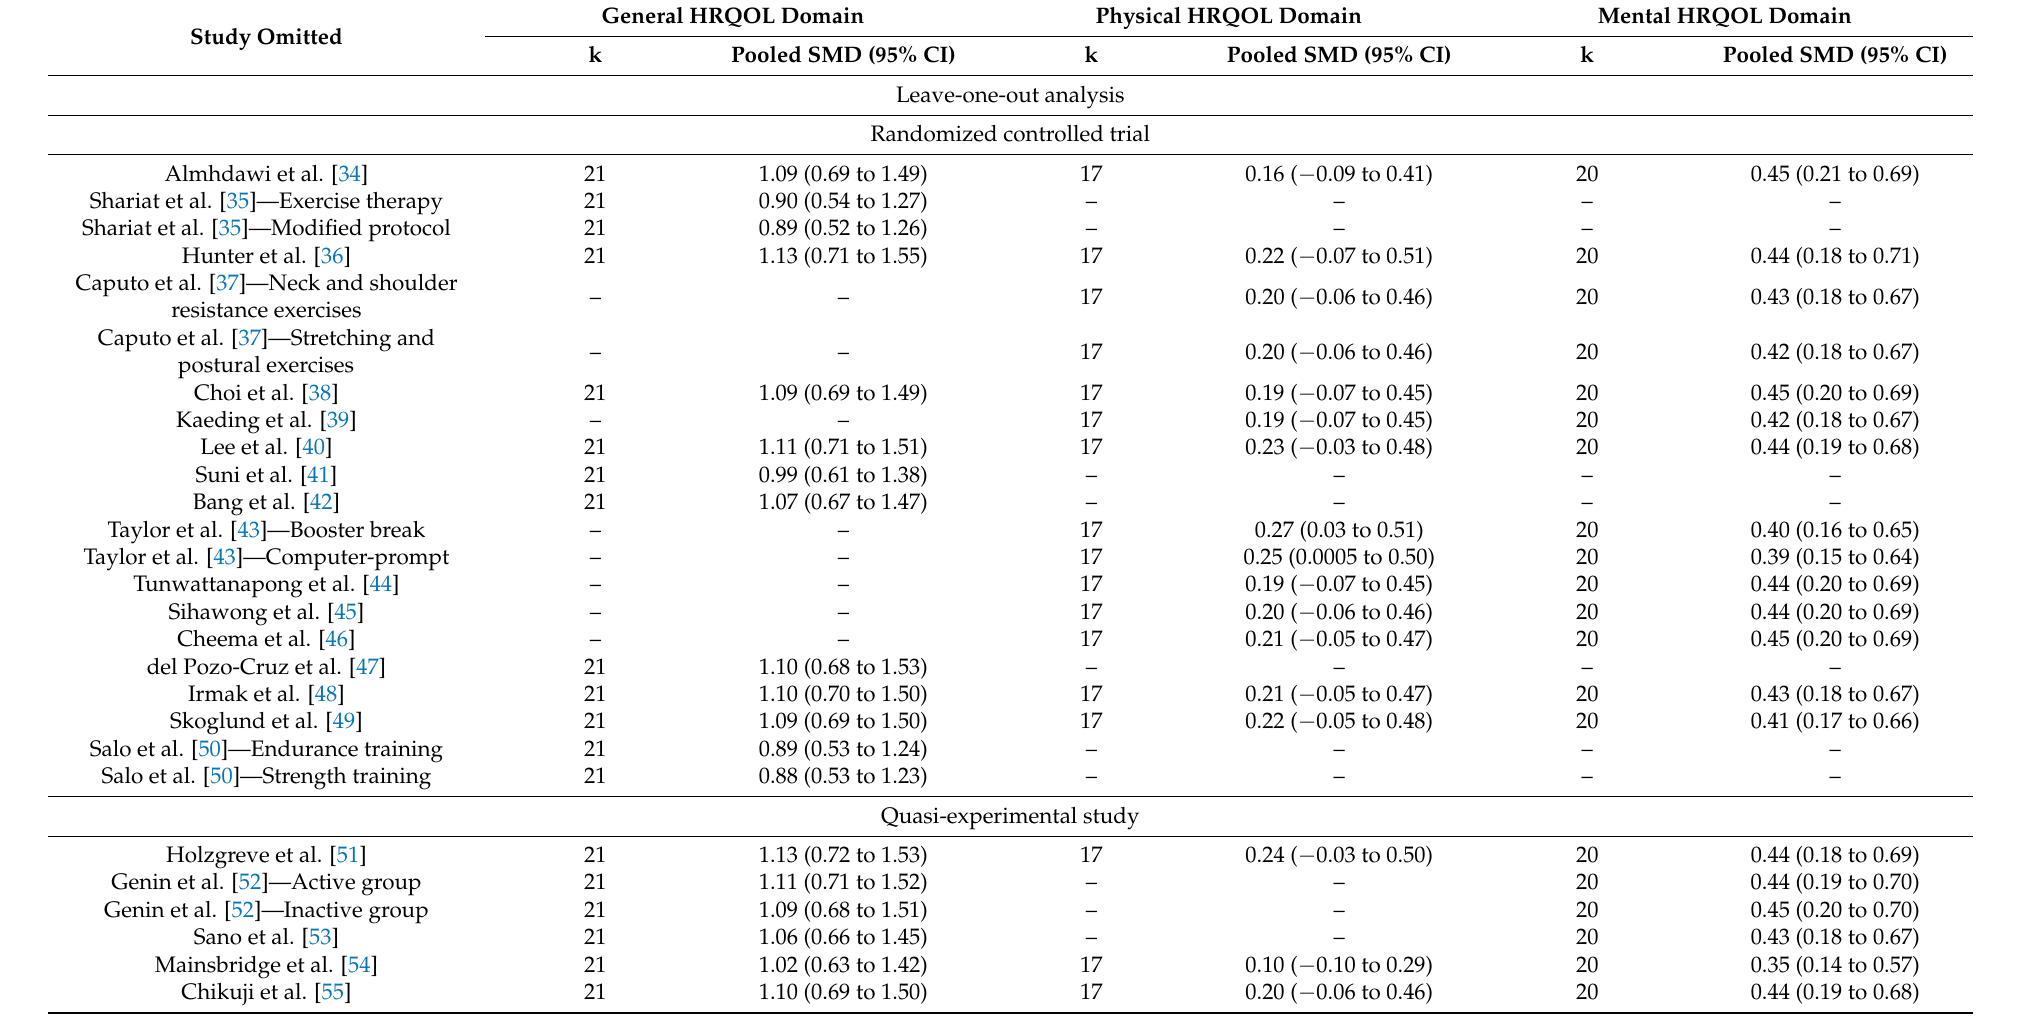
Table 3. Sensitivity analyses for the effects of physical exercise on three HRQOL domains in office